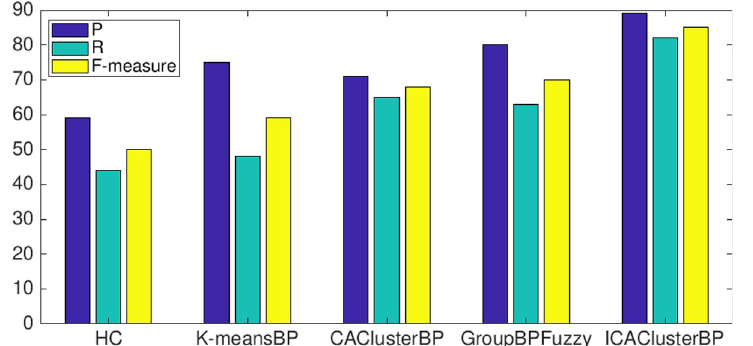
Fig 13. Values of precision, recall, and F-measure in external